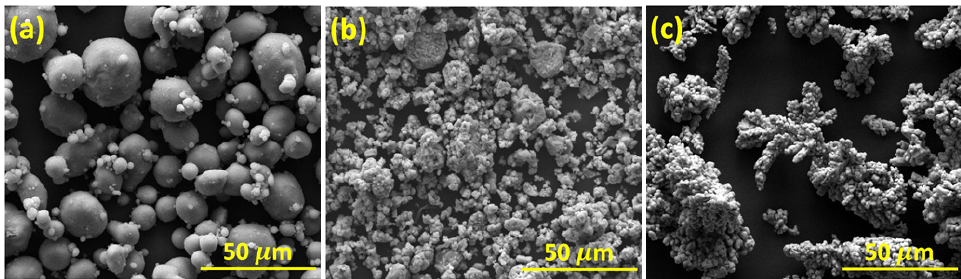
Figure 2. SEM micrograph of starting powders ( a ) Al, ( b ) CuO, and ( c ) Cu. The spherical shape of Al and CuO powders gradually changed to a flattened